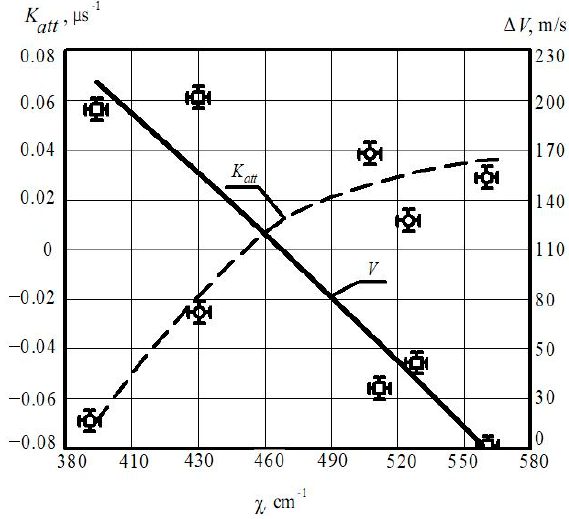
Figure 17. Influence of the value of the curvature-torsion of the crystal lattice ( χ , cm − 1 ) on the attenuation coefficient of the surface acoustic wave ( K att , µ s − 1 ) and the velocity of propagation of the surface acoustic wave ( V , m/s). The symbol means the field of values of the given quantity or the measurement error.